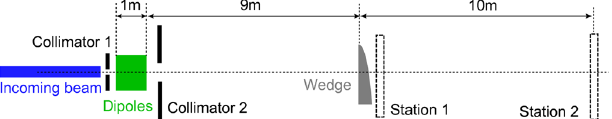
FIG. 8. Schematic layout of the test experiment. The collima- tors are optional, and the dimensions listed are for reference